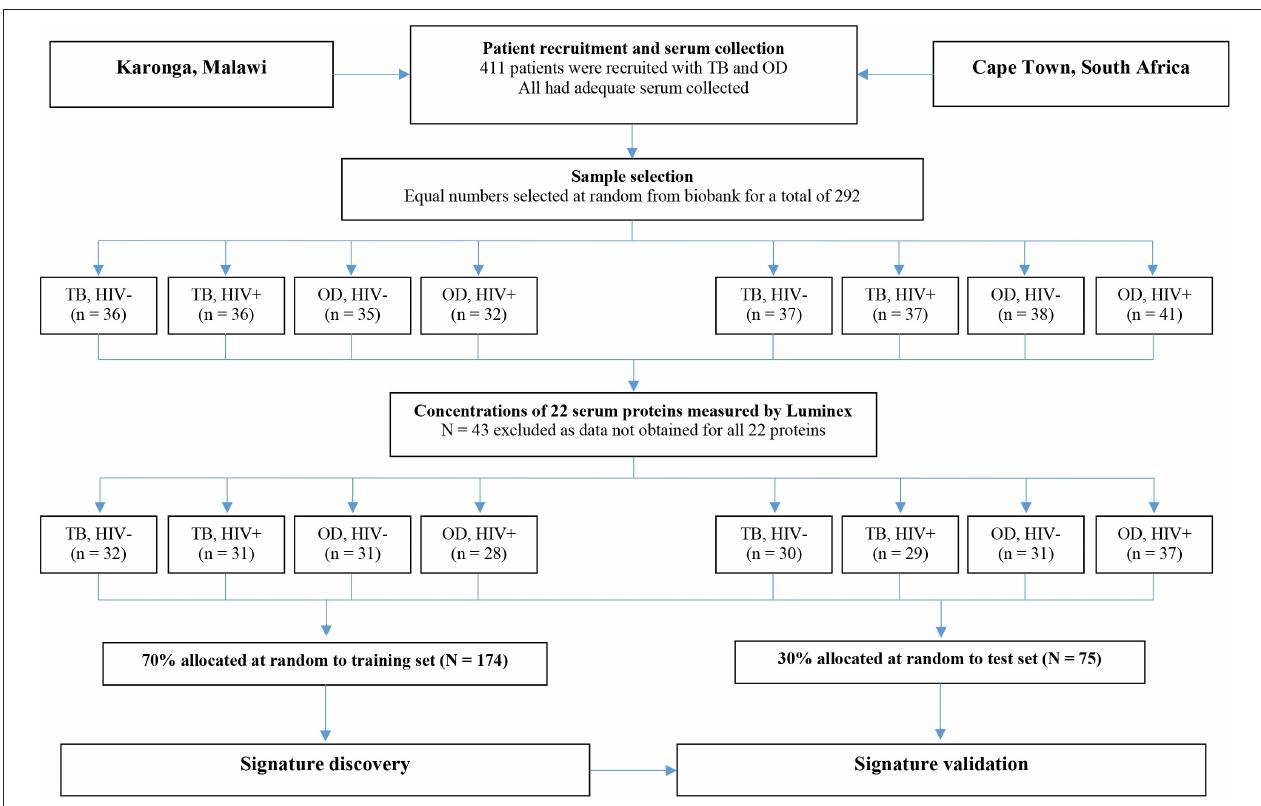
FIGURE 1 | Selection process for inclusion of patients in the biosignature analyses. The flow diagram shows the process from original recruitment to the ILULU-TB study onwards. TB, tuberculosis; OD, other diseases; HIV − , HIV uninfected; HIV + , HIV infected.